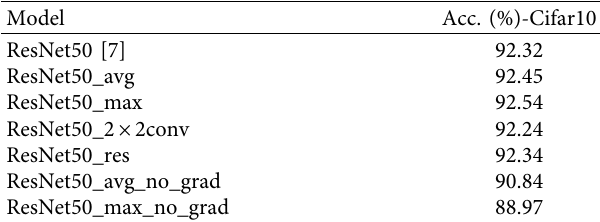
Table 2: Downsampling and gradient blocking